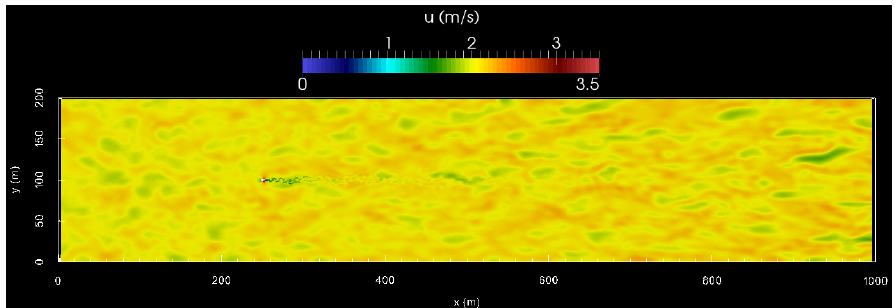
Figure 6. Horizontal slice through the velocity field at z = 16 m and t = 900 s, showing the full extent of the wake behind the cylinder at the scale of the channel.